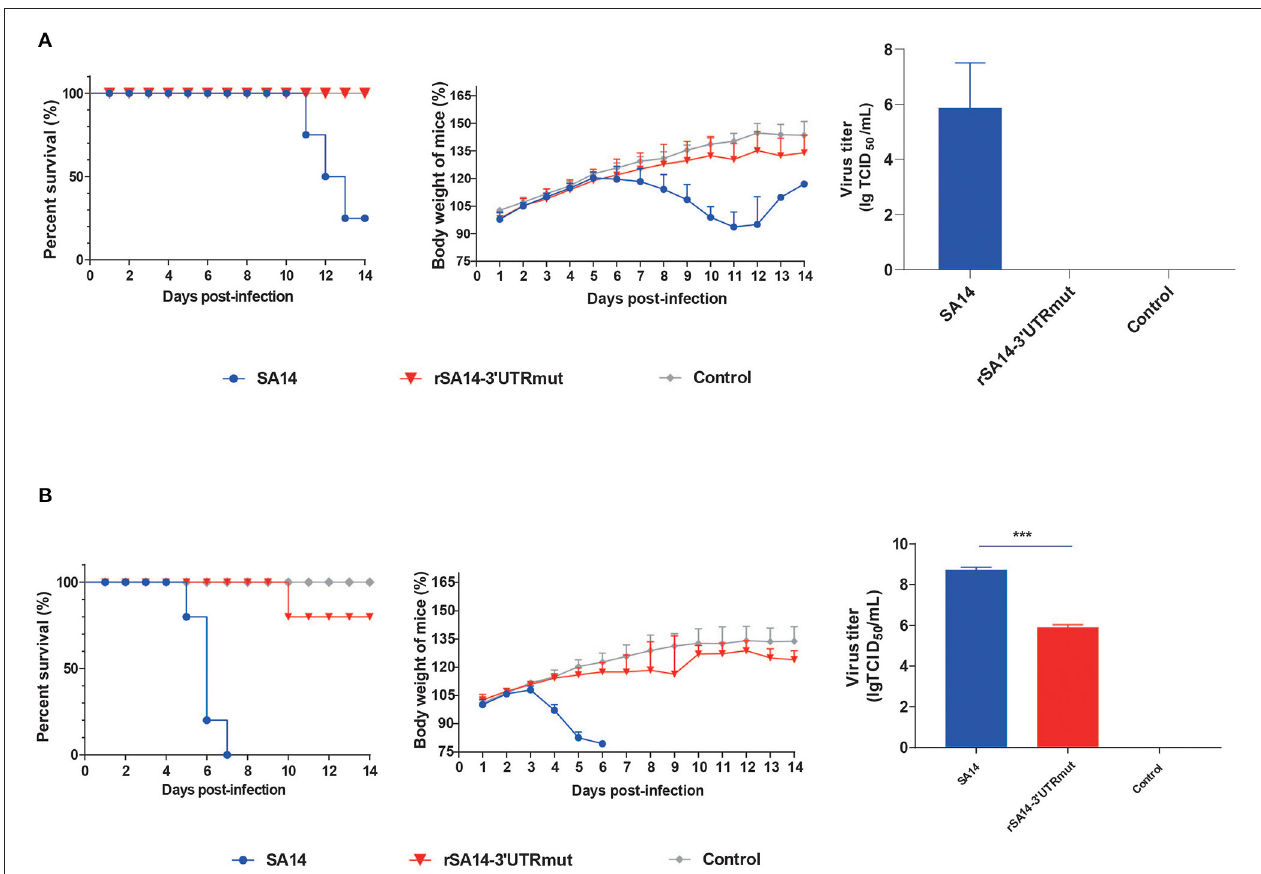
FIGURE 4 | The neuron invasion and pathogenicity in mice. (A) The ability of the virus to invade neurons by the intraperitoneal inoculation route in mice. The SA14 and rSA14-3 ′ UTRmut viruses were injected intraperitoneal into SPF BALB/c mice ( n = 8) using a dose of 10 6 TCID 50 /200 µ L. Survival rate and body weight were monitored daily for 14 days. Then three mice were randomly selected from each group at day seven post-injection. Mouse brain tissues were harvested separately; the virus solution was infected into BHK-21 cells, and the brain virus titer was measured. (B) The pathogenicity of the virus by the intracranially inoculation route in mice. The SA14 and rSA14-3 ′ UTRmut viruses were injected intracranially into SPF BALB/c mice ( n = 8) using a dose of 10 2 TCID 50 /30 µ L. Survival rate and body weight were monitored daily for 14 days. Then three mice were randomly selected from each group at day 3 post-injection. Mouse brain tissues were harvested separately; the virus solution was infected into BHK-21 cells, and the brain virus titer was measured. Mice that lost more than 25% of their initial weight were euthanized. The percentage weight from each group and each time point are presented as means ± SD ( n = 3) and the significance was calculated using an unpaired t -test ( *** P <